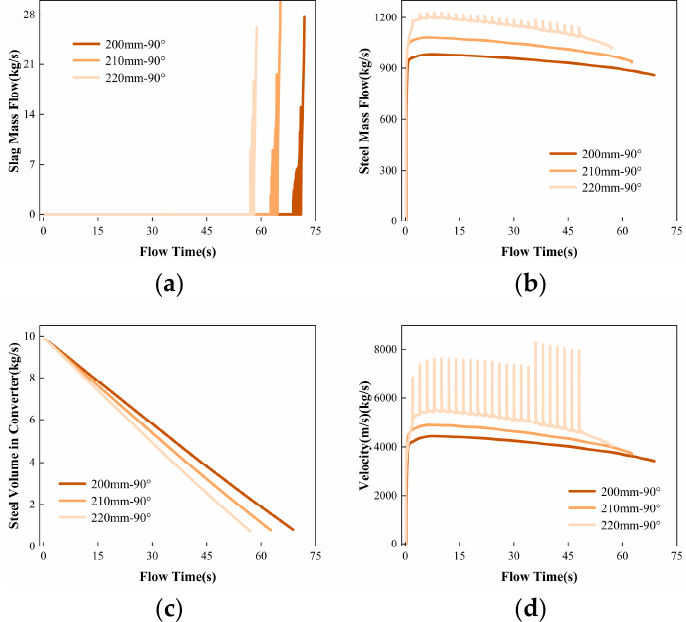
Figure 9. The variation trend of ( a ) slag mass flow; ( b ) steel mass flow; ( c ) steel volume in converter, and ( d ) tapping velocity with flowing time when the tilting hole sizes of the converter are 200 mm, 210 mm, or 220 mm.